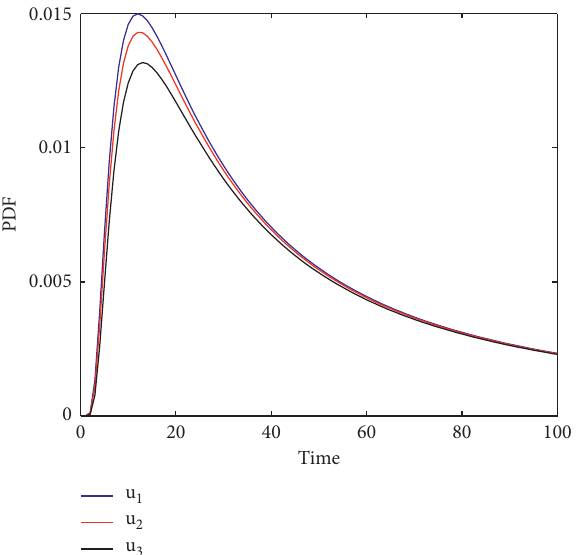
Figure 4: The reliability of social tie for system (2) with initial conditions given in Example